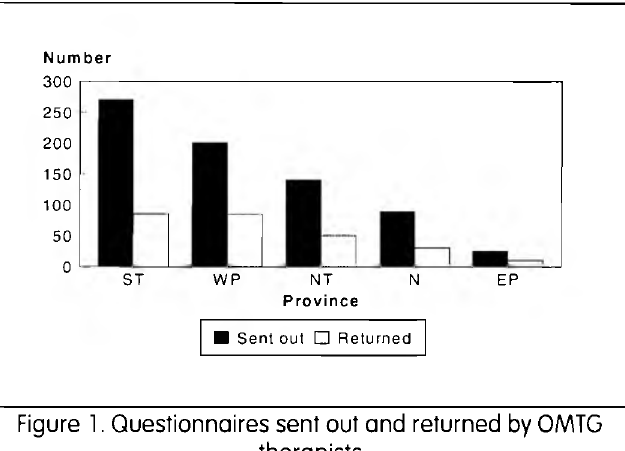
Figure 1. Questionnaires sent out and returned by OMTG